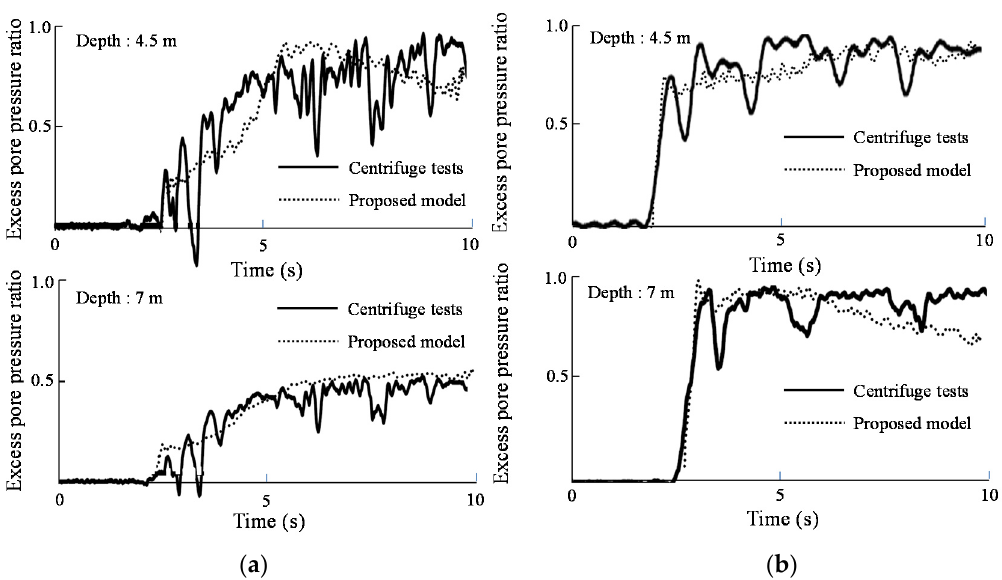
Figure 9. Comparison of excess pore pressure ratio in the free-field zone: ( a ) Case 1 (D r = 55%) and ( b ) Case 2 (D r = 35%).